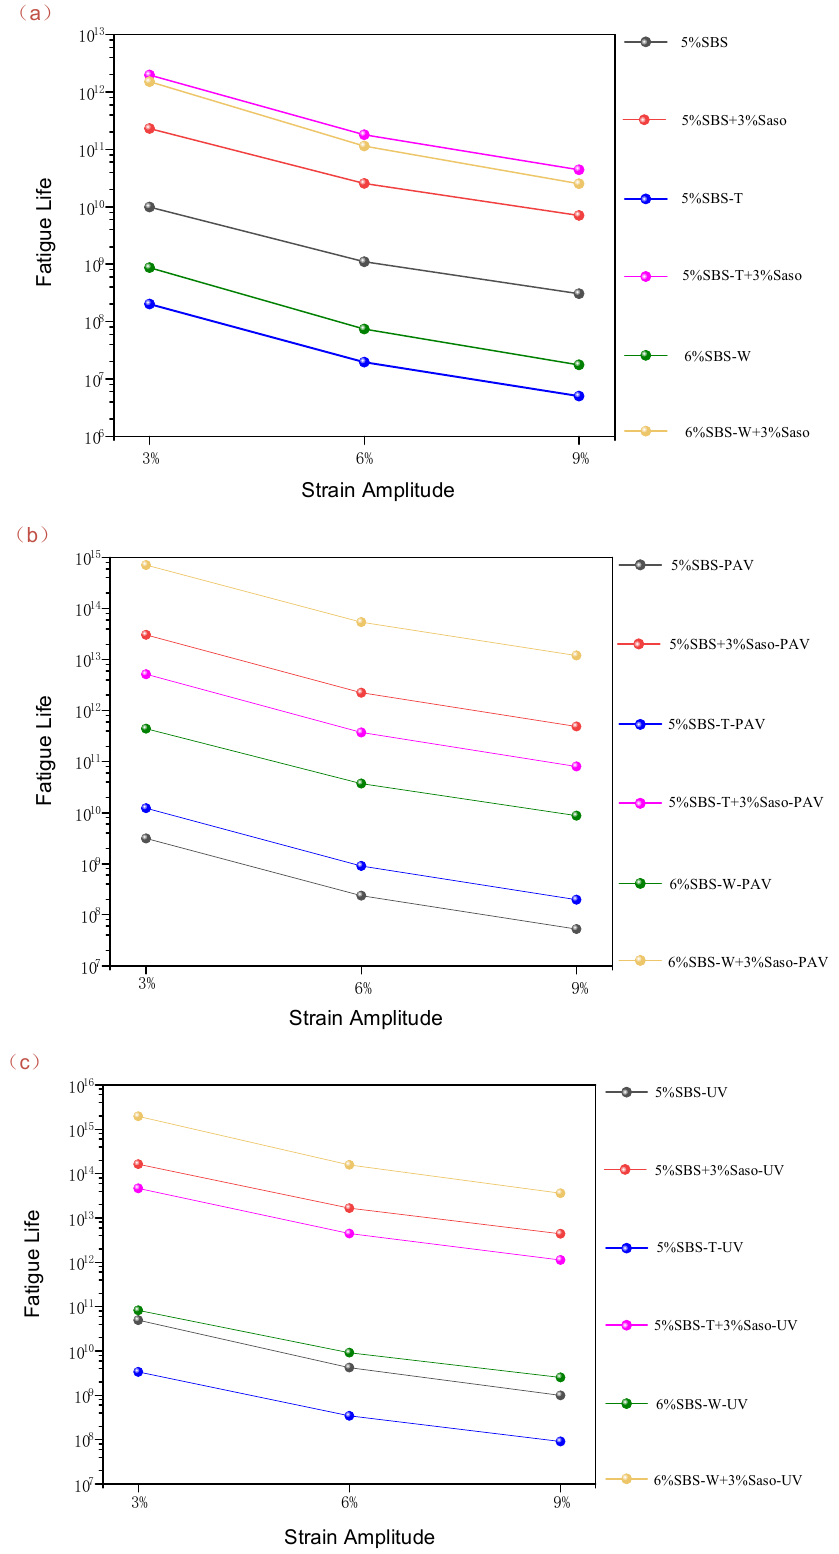
Figure 8. Fatigue life of modified asphalt binder under different strain levels. ( a ) SBS/Saso; ( b ) SBS-T/Saso; ( c )